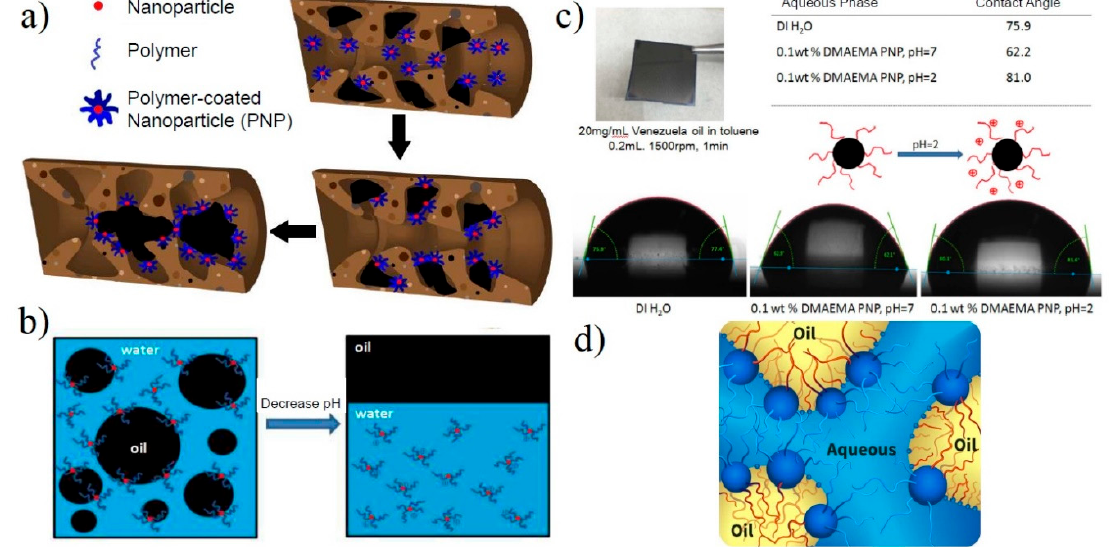
Figure 4. Schematic of ( a ) the use of polymer-coated NP additives to recover heavy oil trapped in porous media, ( b ) the demulsification of oil-in-water emulsions with changes in solution pH, ( c ) wettability alteration by polymer-coated NPs [40] and ( d ) schematic of oil–water microemulsion phases with polymer-coated NP additives [41].